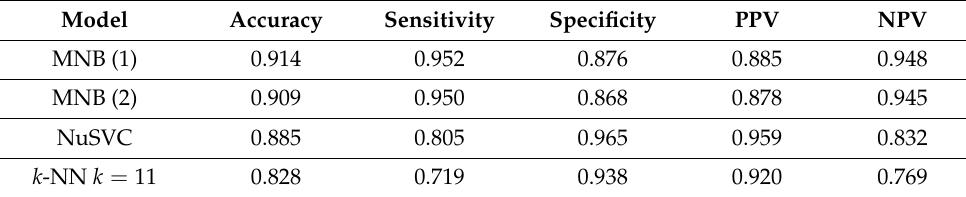
Table 15. Evaluation of the chosen classifiers performance in Substage